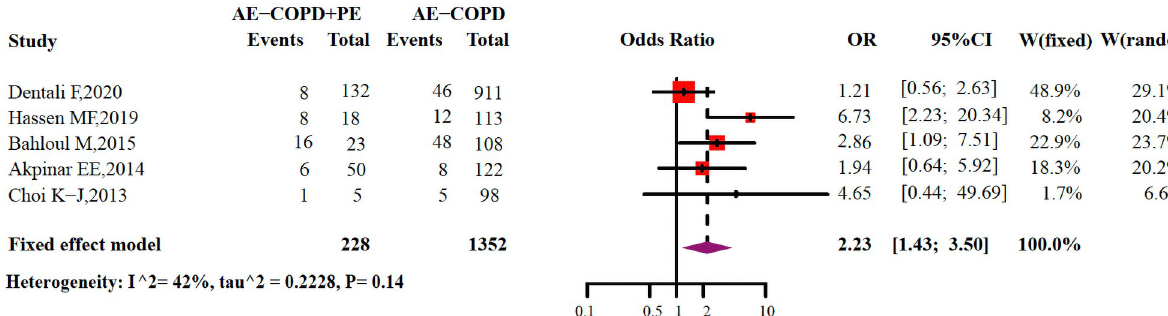
Fig 4. Meta-analysis of studies reporting mortality data.